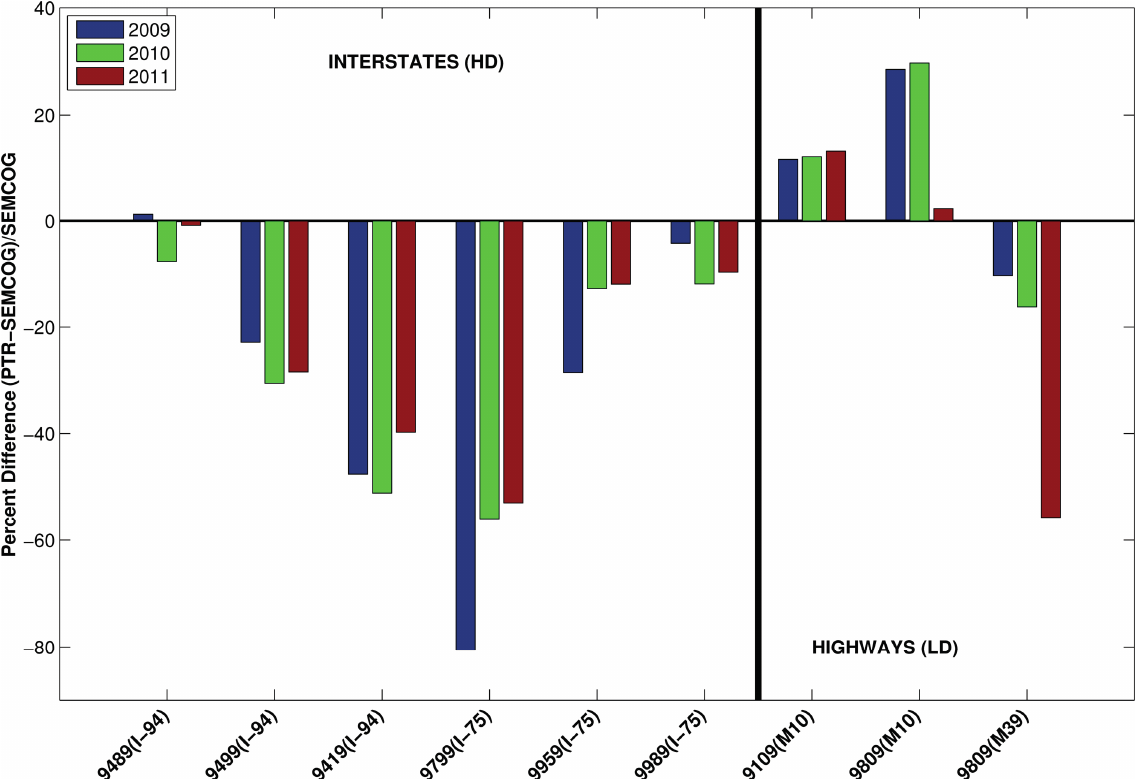
Figure 10. Comparison of AADT from SEMCOG TDM runs versus measured AADT at selected MDOT PTR locations, shown as percent difference. This figure contains measurements at multiple locations (each group of bars); the interstates are shown on the left side of the figure and the highways are shown on the right side of the